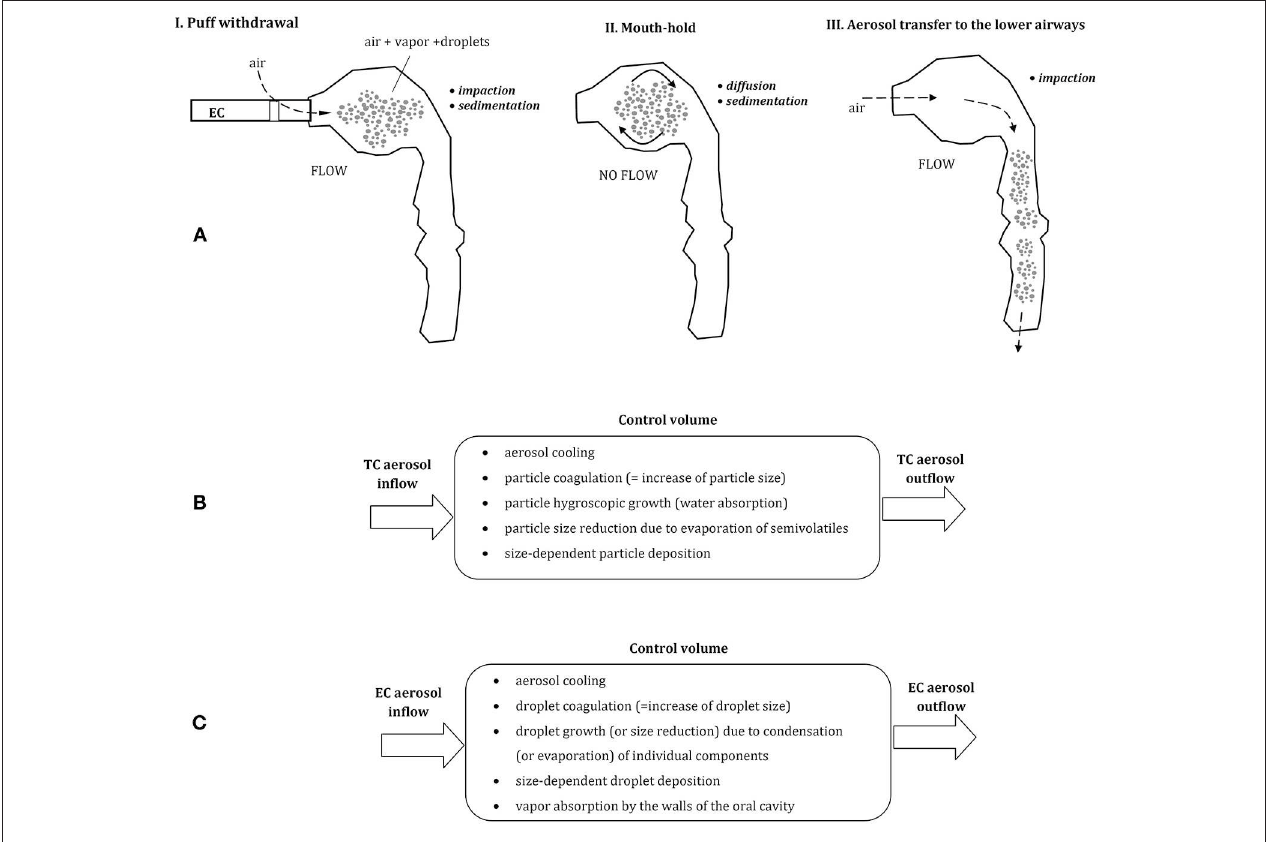
FIGURE 1 | (A) Three phases of vaping: puff withdrawal, aerosol mouth-hold, and aerosol inhalation (the predominant aerosol droplets deposition mechanisms are indicated). Below—the comparison of thermodynamic and mass transfer effects after inhalation of aerosol from tobacco cigarette, TC (B) and electronic cigarette, EC (C) ; all these processes take place simultaneously inside a control volume (e.g., a small segment of the oral